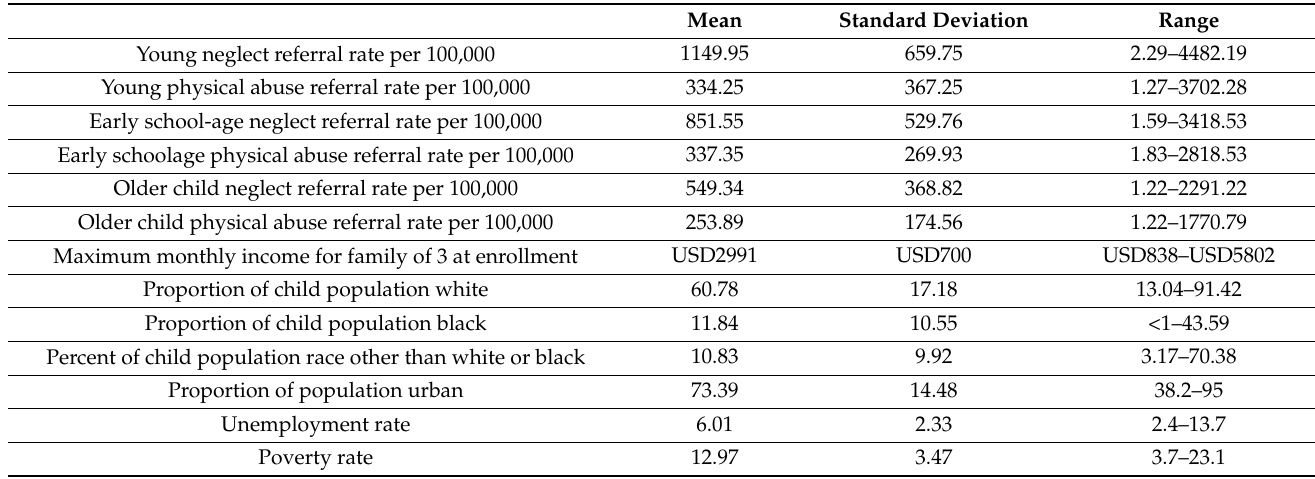
Table 1. Descriptive Statistics, N = 2192 state/quarters.